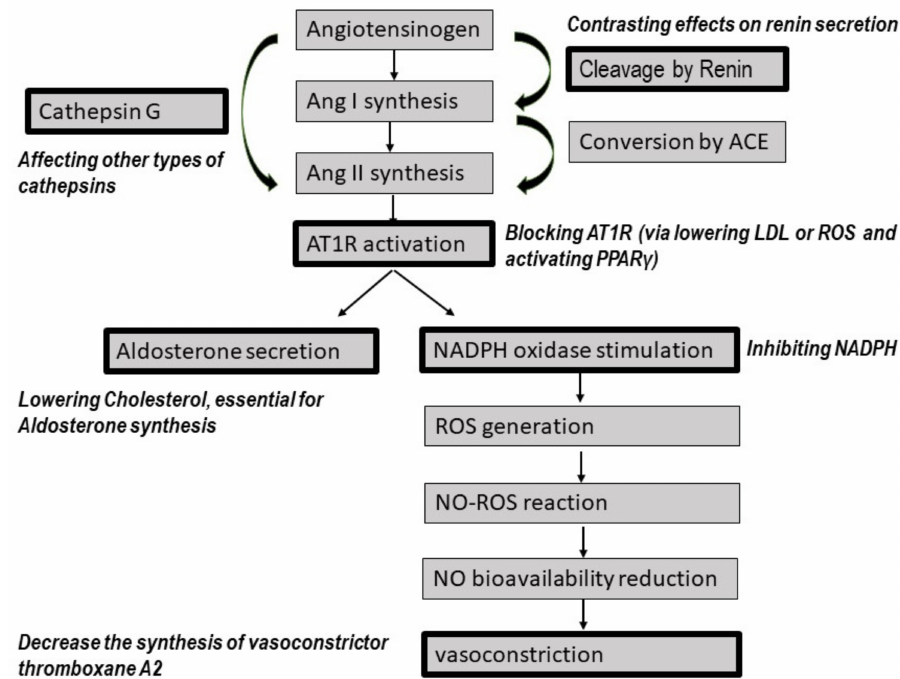
Figure 1. The effect of statins on RAS pathways. Statins affect renin secretion, aldosterone secretion, and vasoconstriction. Statins also block AT1Rs, increase ACE2 expression and NO release. The steps of pathways that are affected by statins are shown in black. Ang: angiotensin, ACE: angiotensin- converting enzyme, AT1Rs: angiotensin type 1 receptors, LDL: low-density lipoprotein, ROS: reactive oxygen species, PPAR: peroxisome proliferator-activated receptor, NADPH: nicotinamide adenine dinucleotide phosphate, NO: nitric oxide, NEP: neprylisin, MasR: Mas receptors. Blocking the harmful RAS pathway (AT1R activation) has many clinical